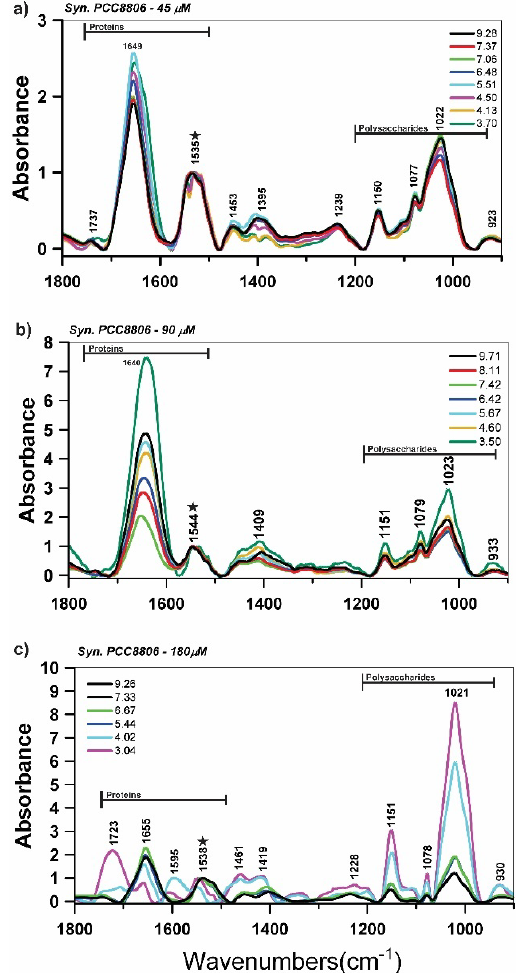
Figure 1. Attenuated total reflectance Fourier transform infrared (ATR-FTIR) spectroscopy spectra of Synechococcus sp. PCC8806 ( Syn. PCC8806) at different pH values in the titration experiments with the freeze-dried cells grown in ( a ) 45 µ M, ( b ), 90 µ M, and ( c ) 180 µ M of P concentrations. The (cid:70) indicates the amide II band used for spectra